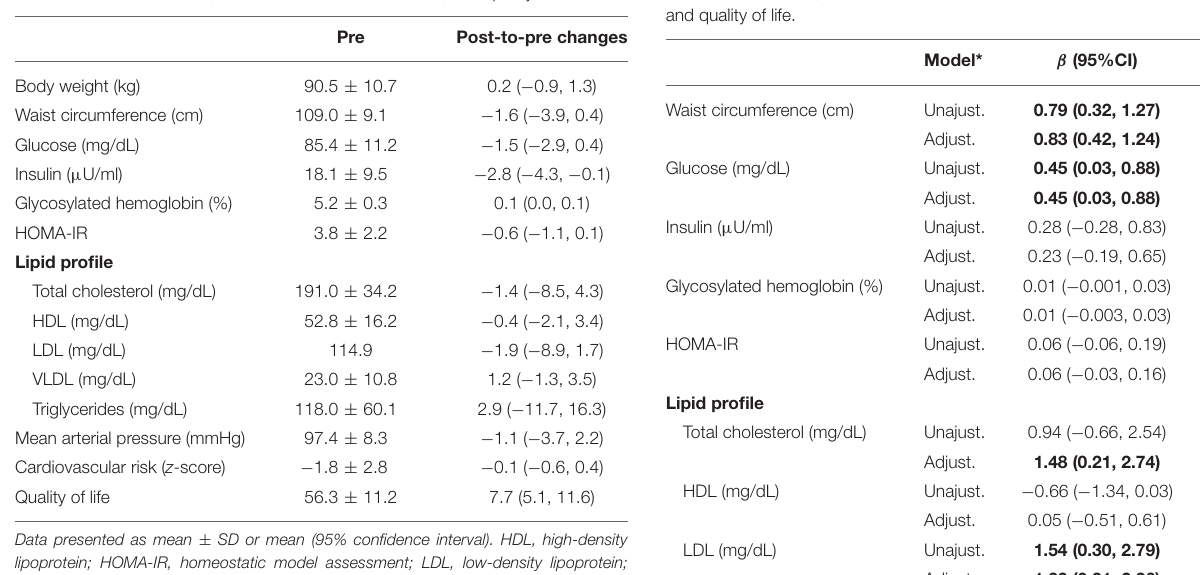
TABLE 1 | Baseline values and delta changes for anthropometric measures, cardiovascular risk factors, clustered cardiometabolic risk, and quality of life.